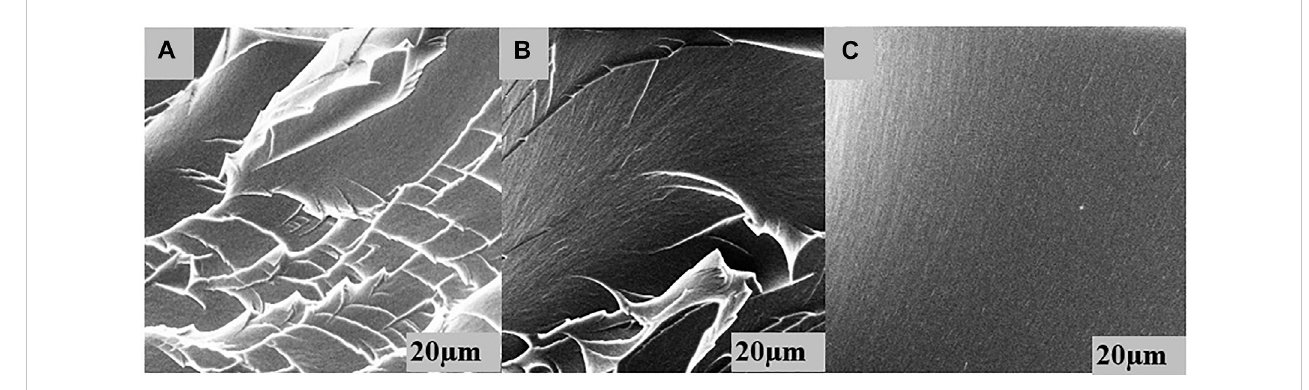
FIGURE 7 A cross - section view of the microstructures visible on fractured surfaces of dried PEGDA/gelatin hydrogel samples of (A) P29G1, (B) P26G4 and (C) P21G9 at 6